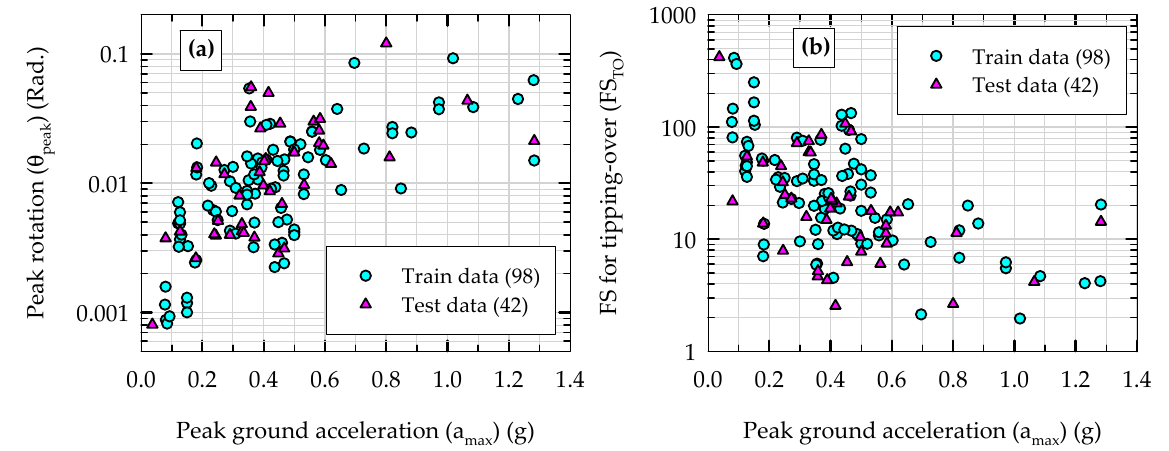
Figure 6. Initial split of experimental data for training and testing of machine learning models (70–30% split) showing the variations of ( a ) peak rotation and ( b ) factor of safety for tipping over with peak ground acceleration.